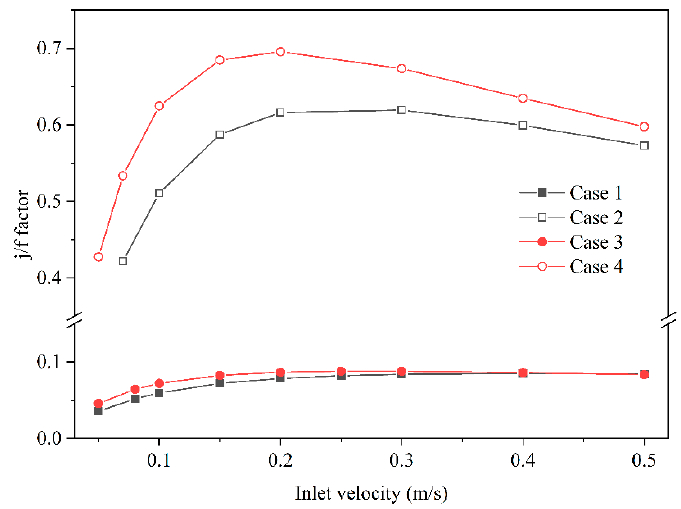
Figure 9. Variations of the j/f factor with the inlet velocity change for Cases 1–4.